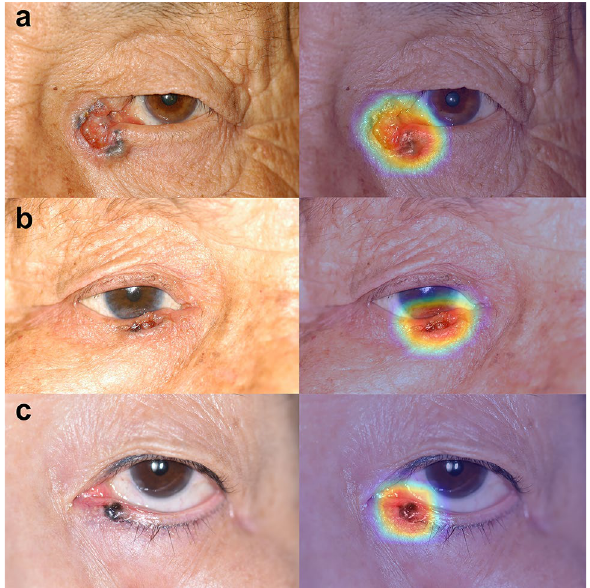
Figure 3. Representative gradient-weighted class activation mapping images of the EfficientNetV2-M model. In differentiating malignant ( a – c ) eyelid lesions, figures are shown in pairs of the original eyelid image (left) and corresponding activation mapping image